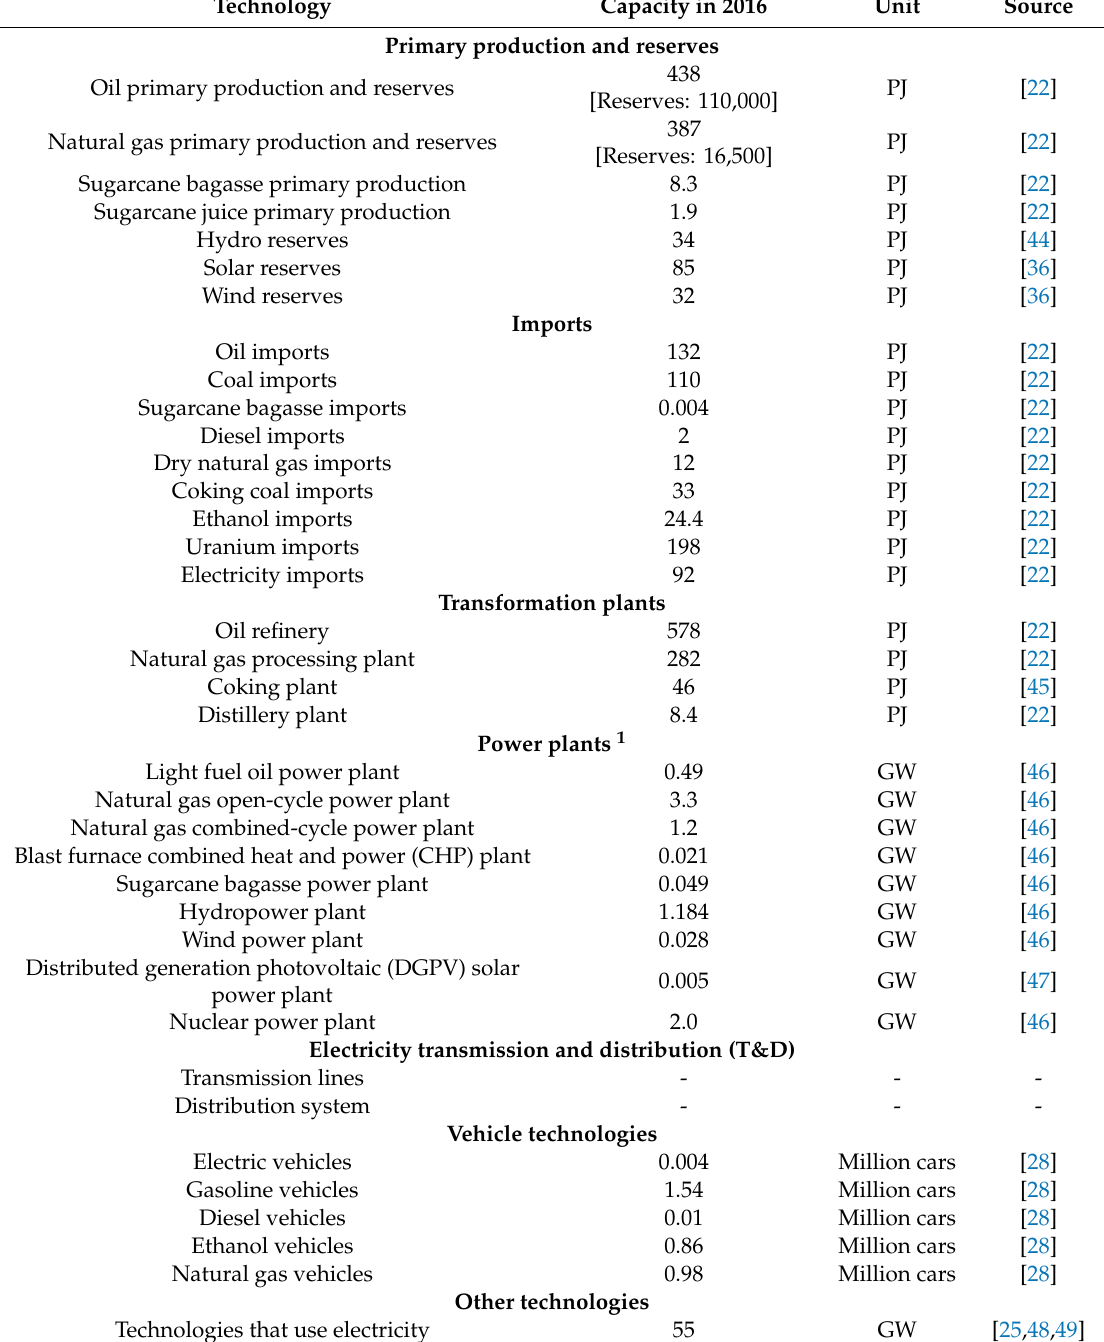
Table 3. Capacity of technologies in RJ state’s RES in